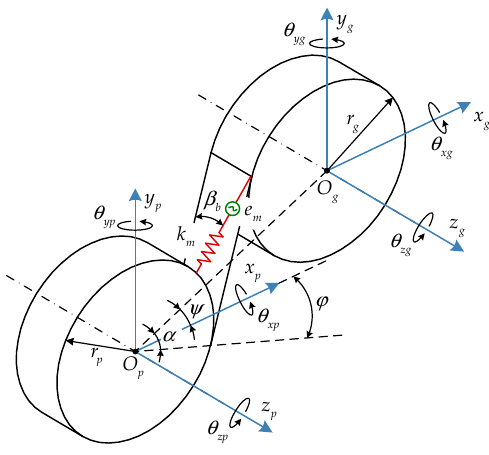
Figure 6. Dynamic model of gear mesh element.